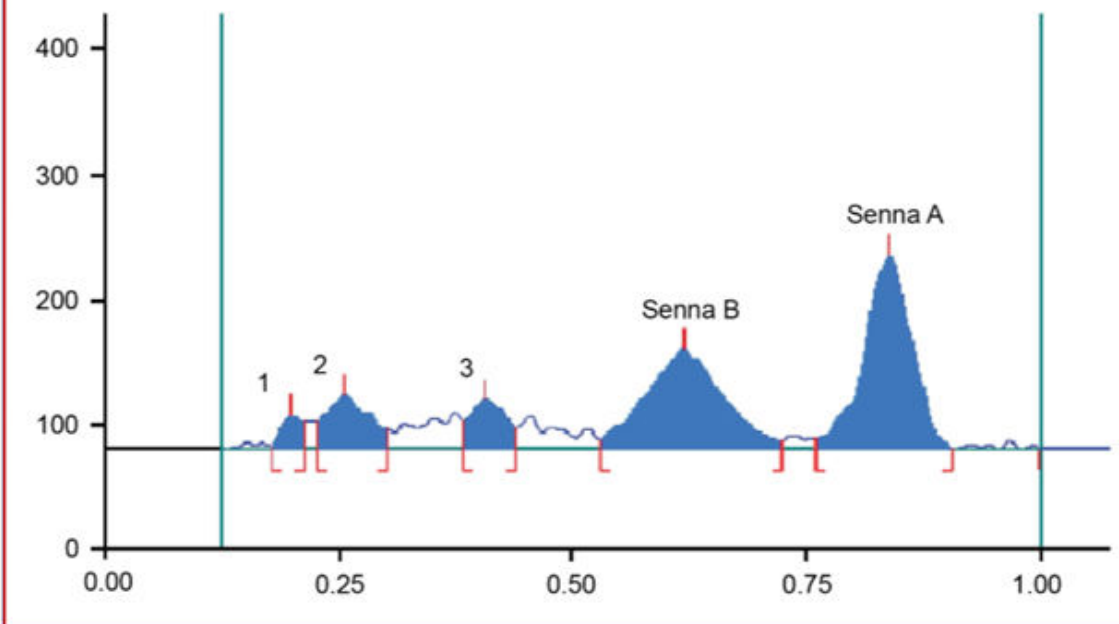
Figure 2: Scan (at 350 nm) showing the separation of sennoside A and B in the extract of a laxative